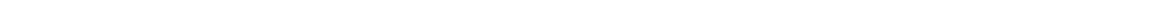
Fig. 1 Identi fi cation of a CD24 − CD73 − γδ T17 cell subset in WT thymus. a , b Schematic of γδ T cell differentiation in adult thymus, and developmental pro fi le of γδ T cells in a E14.5 FTOC cultured for the indicated time points and b ex vivo thymocytes from E17.5 embryos, day 1 and day 7 neonatal mice, and weeks 4, 7, and 12 adult mice. c Frequencies of ROR γ t + and ROR γ t − cells among all γδ T cells in WT E17.5, day 1, and day 7 ex vivo thymus, and FTOC day 7 and 10. d , e Representative FACS plots of the CD24/CD73 pro fi les of ROR γ t + d and ROR γ t − e γδ T cells. f Quanti fi cation of the proportions of CD24/CD73 developmental subsets within ROR γ t + vs. ROR γ t − γδ T cells. g Representative FACS plots of CD24/CD73 subsets in spleen, lungs and gut of WT (HEB fl / fl ) mice. All plots are gated on CD3 + TCR γδ + cells. Numbers in FACS plots indicate frequency within each gate. Data are representative of at least two experiments with 3 mice per group. Center values indicate mean, error bars denote s.e.m. p- values were determined by two tailed Student's t -test. NS = not signi fi cant NATURE COMMUNICATIONS | 8: 2004 | DOI: 10.1038/s41467-017-02225-5 |